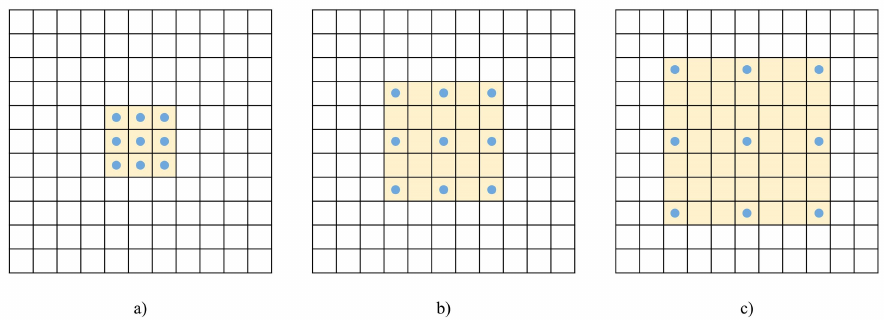
Figure 3. The convolution and dilated